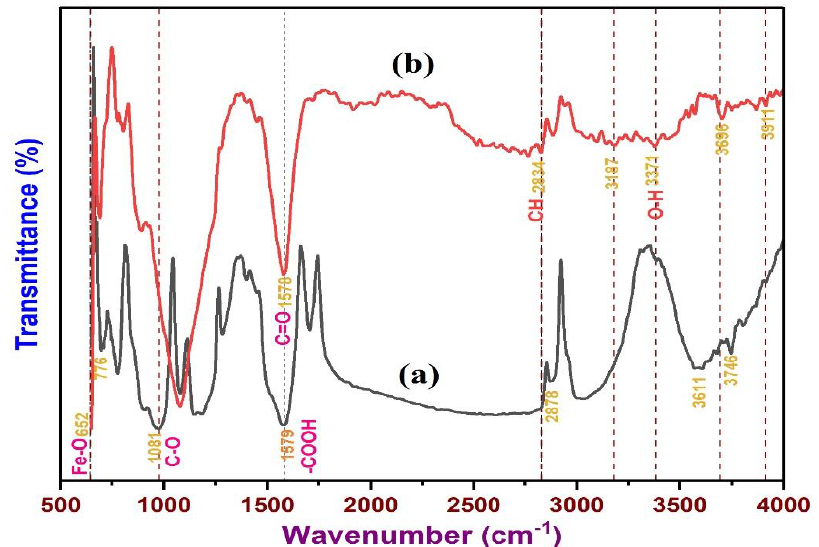
Figure 6. Fourier transform infrared spectra of NBC (a) and MBC